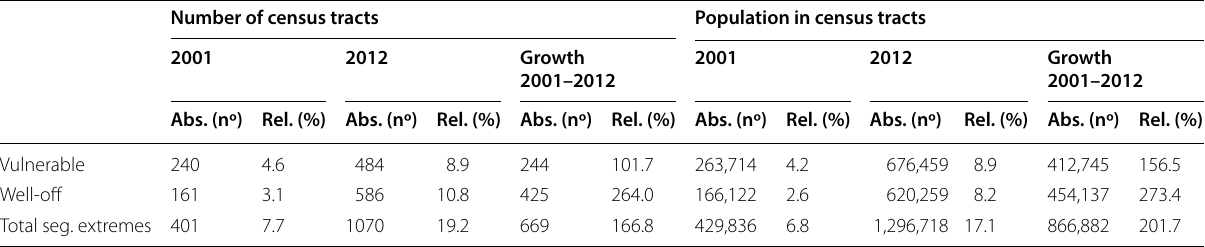
Table 1 Census tracts and population with extreme values of segregation. Source: Own elaboration from the data provided by Barris i crisi (Blanco and Nel lo ·